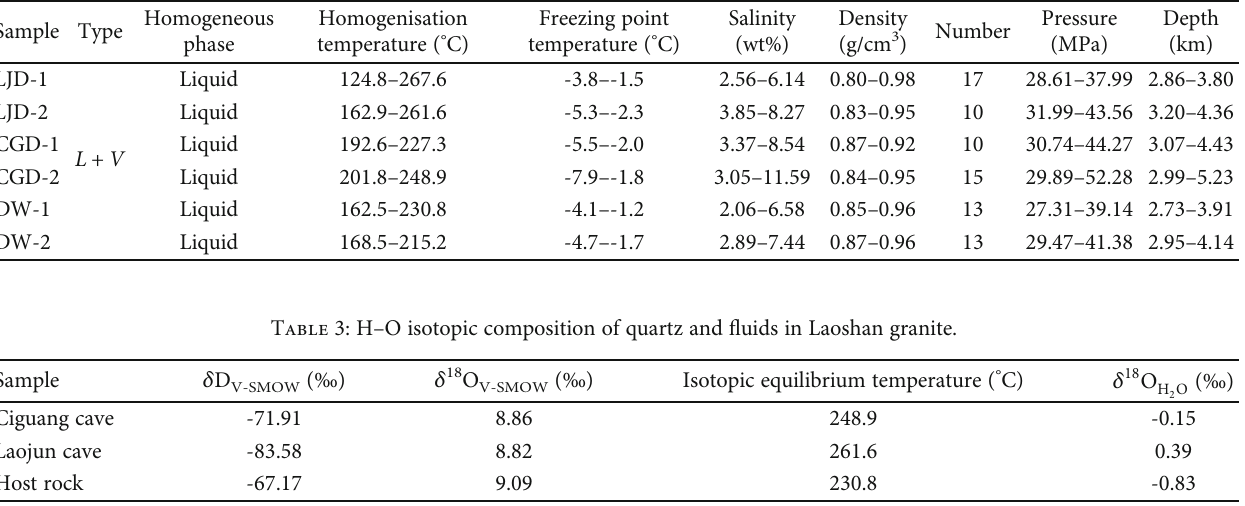
Table 2: Microscopic temperature results of fl uid inclusion.